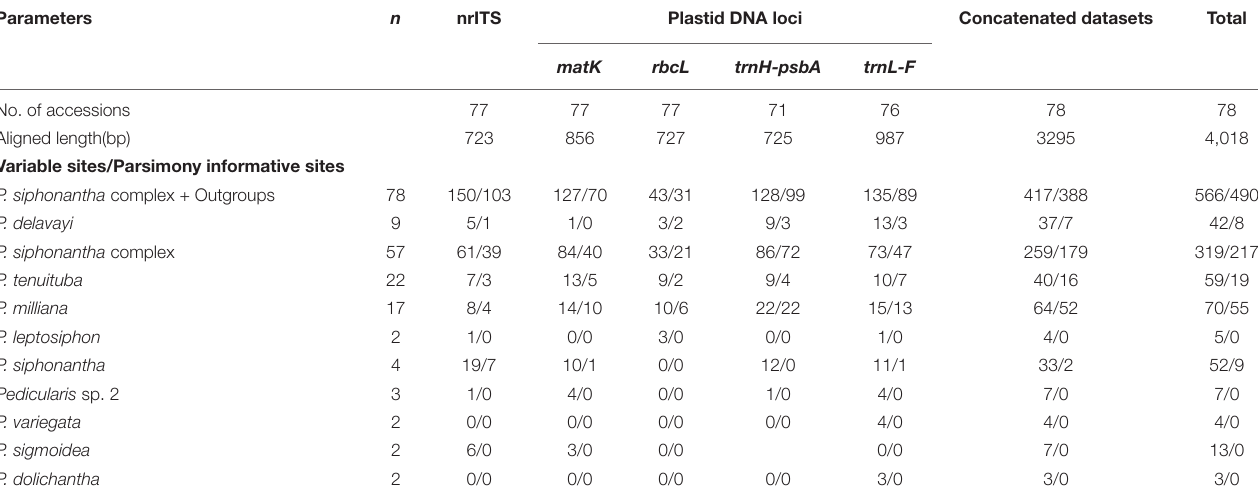
TABLE 2 | Sequence characteristics of nrITS and four plastid DNA regions. Parameters n nrITS Plastid DNA loci Concatenated